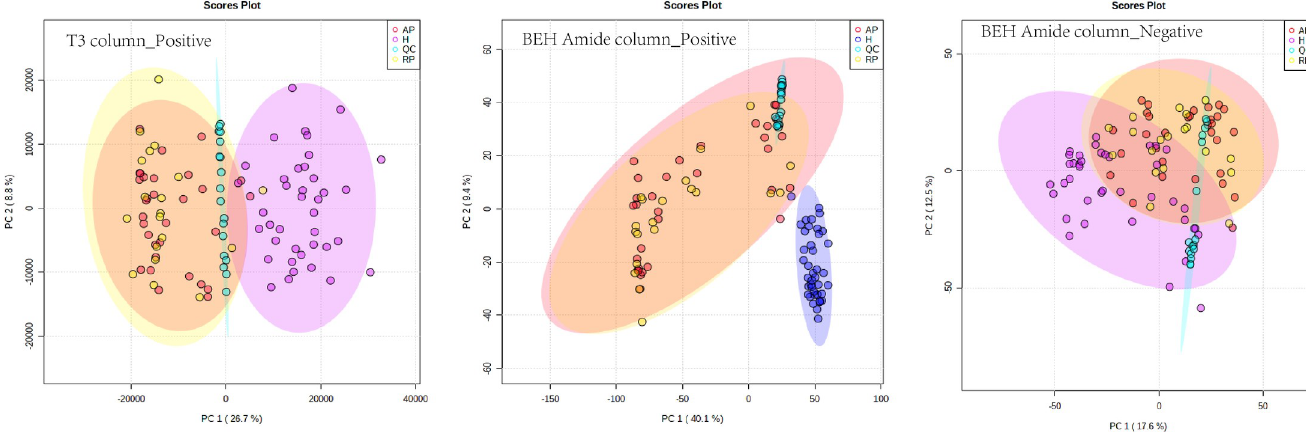
Fig 1. PCA models created using data obtained through LC-ESI-TOF-MS analysis in positive ionization mode on a T3 column (PC 1 = 26.7%, PC 2 = 8.8%), amide column (PC 1 = 40.1%, PC 2 = 9.4%), and in negative mode on an amide column (PC 1 = 17.6, PC 2 = 12.5%). Red, purple, blue, and yellow solid circles correspond to AP, healthy, QC, RP patients, respectively.